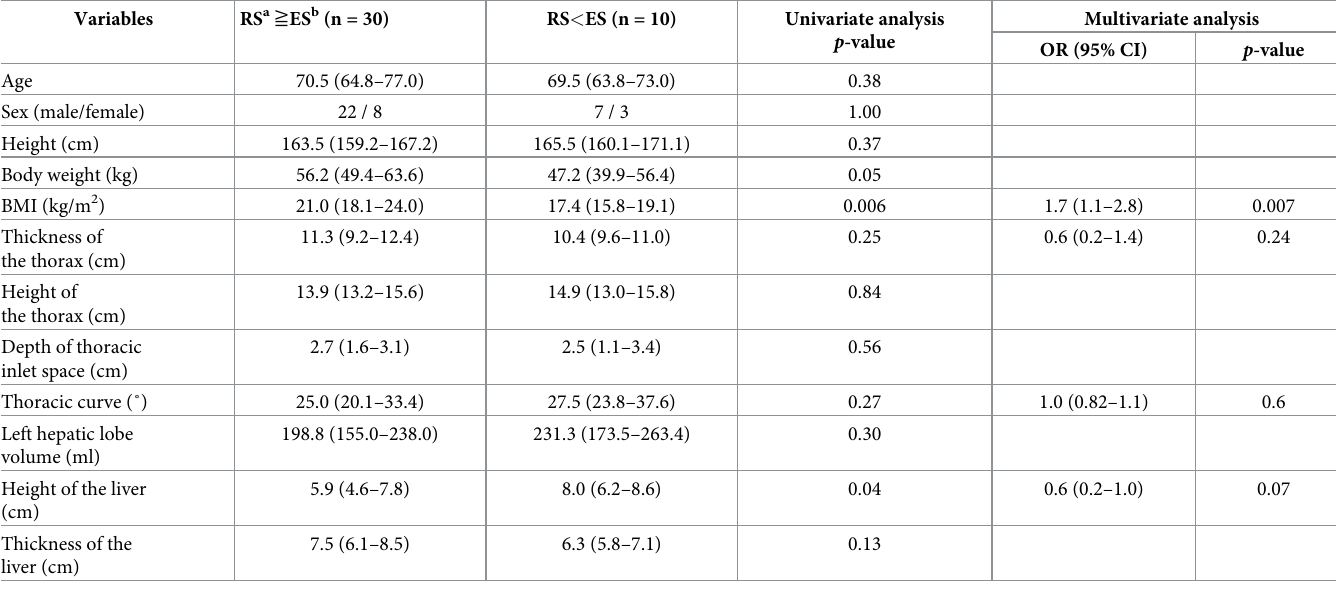
Table 3. Relationship between factors and reconstruction